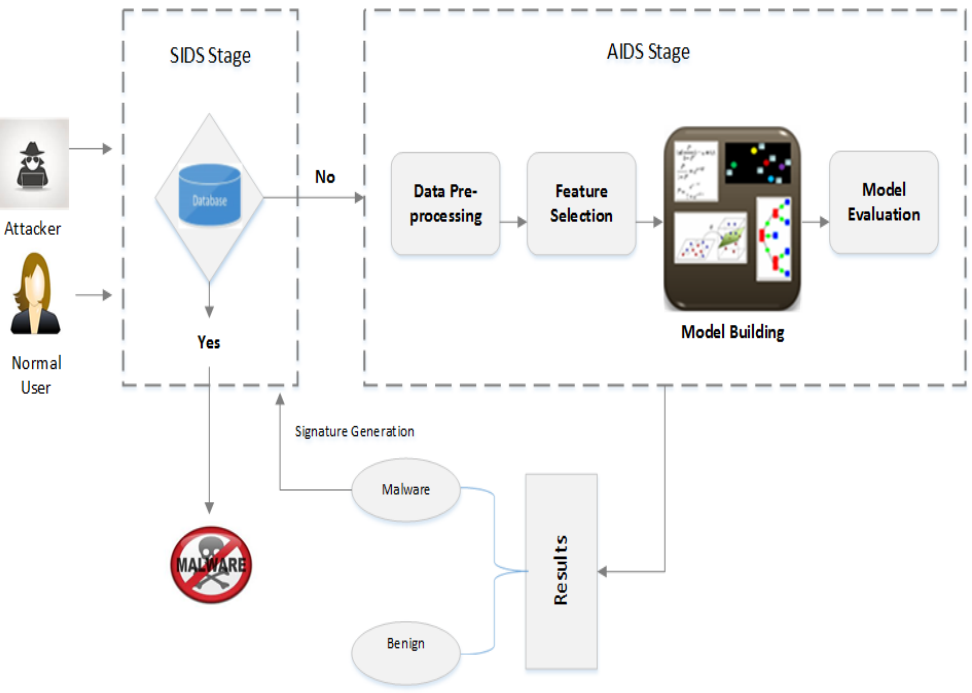
Figure 1. Hybrid intrusion detection system .